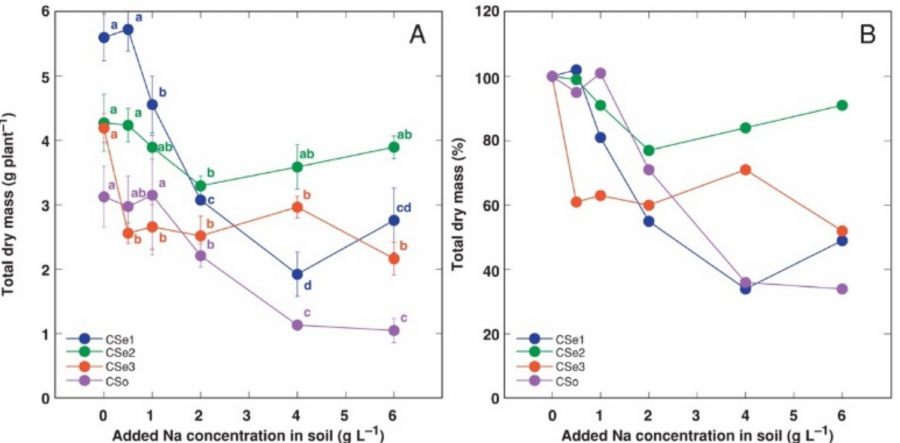
Figure 1. Effect of increasing soil salinity on total dry mass ( A ) and total dry mass relative to control plants ( B ) of Calystegia sepium accessions CSe1, CSe2, CSe3 and Calystegia soldanella (CSo). Na + was added in a form of NaCl. Data are means from five replicates for each concentration ± SE. Different letters of the respective color indicate statistically significant differences ( p < 0.05) between treatments for the respective model